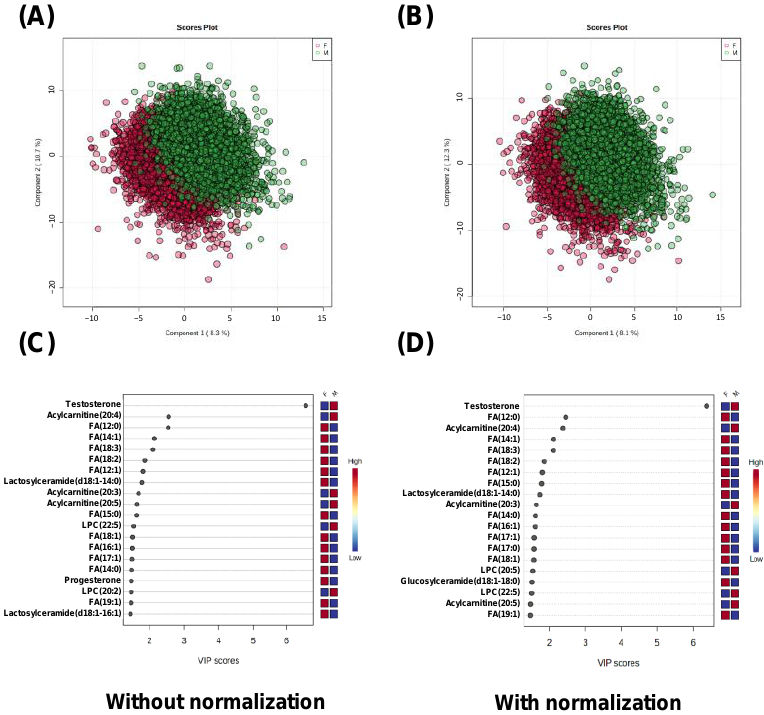
Figure 5. The relationship between gender and metabolomic profile using PLS-DA. ( A , B ) Score plots. ( C , D ) VIP scores. ( A , C ) Analytical results using the data without normalization and ( B , D ) analytical results using the data with normalization.